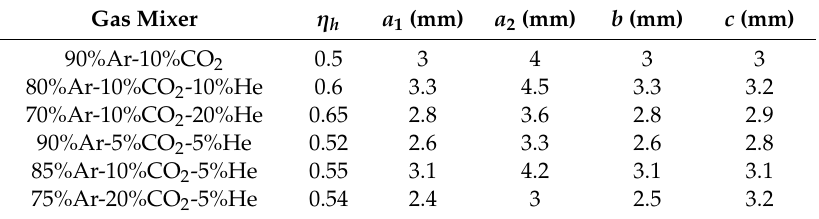
Table 5. Heat source model geometry under different shielding gases.